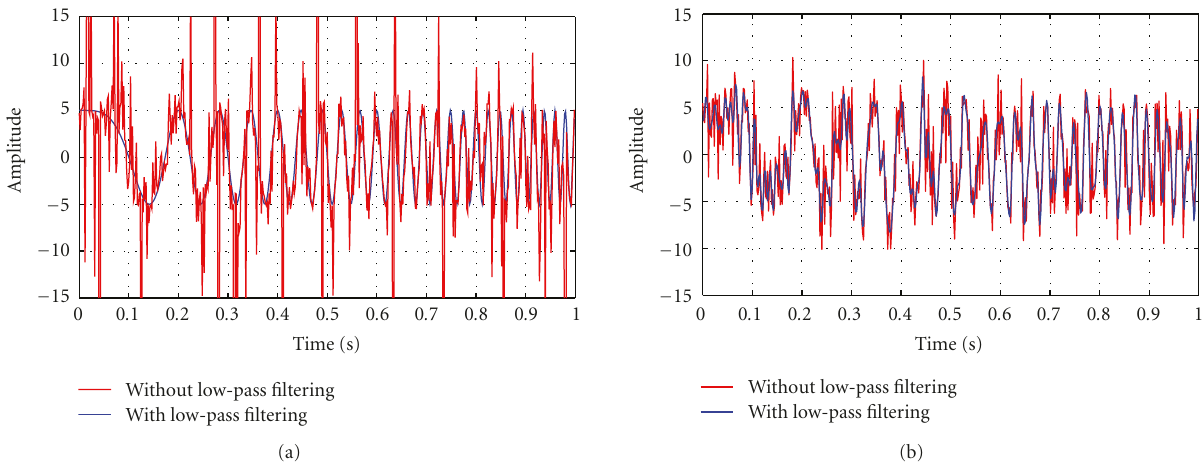
Figure 14: The TS s 2 ( n ) corrupted by noise with Cauchy PDF ( γ = 1) (a) and its estimate obtained by RDFT filtering approach based on CENS-method